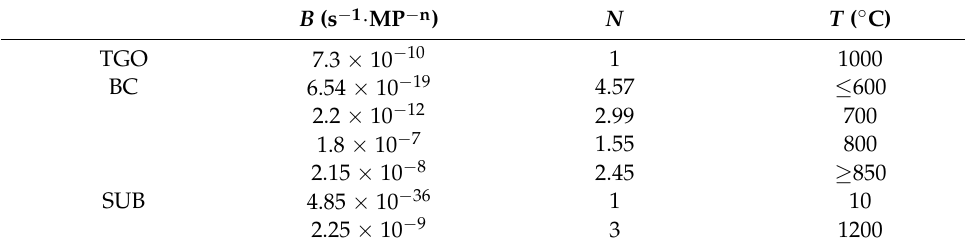
Table 2. Creep data for the TGO, BC, and SUB layer